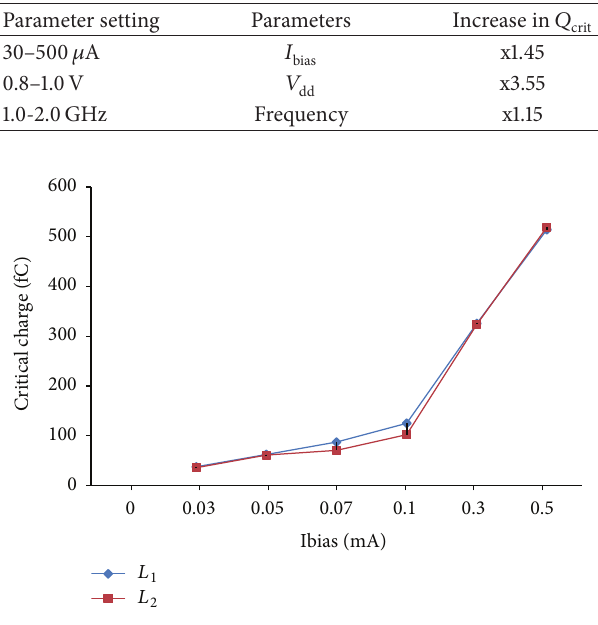
Figure 4: Critical charge against bias current for different Leff at 1.0